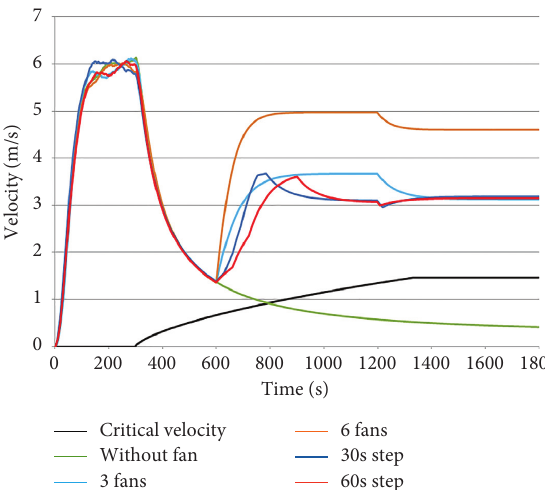
Figure 8: Comparison of algorithms of ventilation control for 5 MW fire.